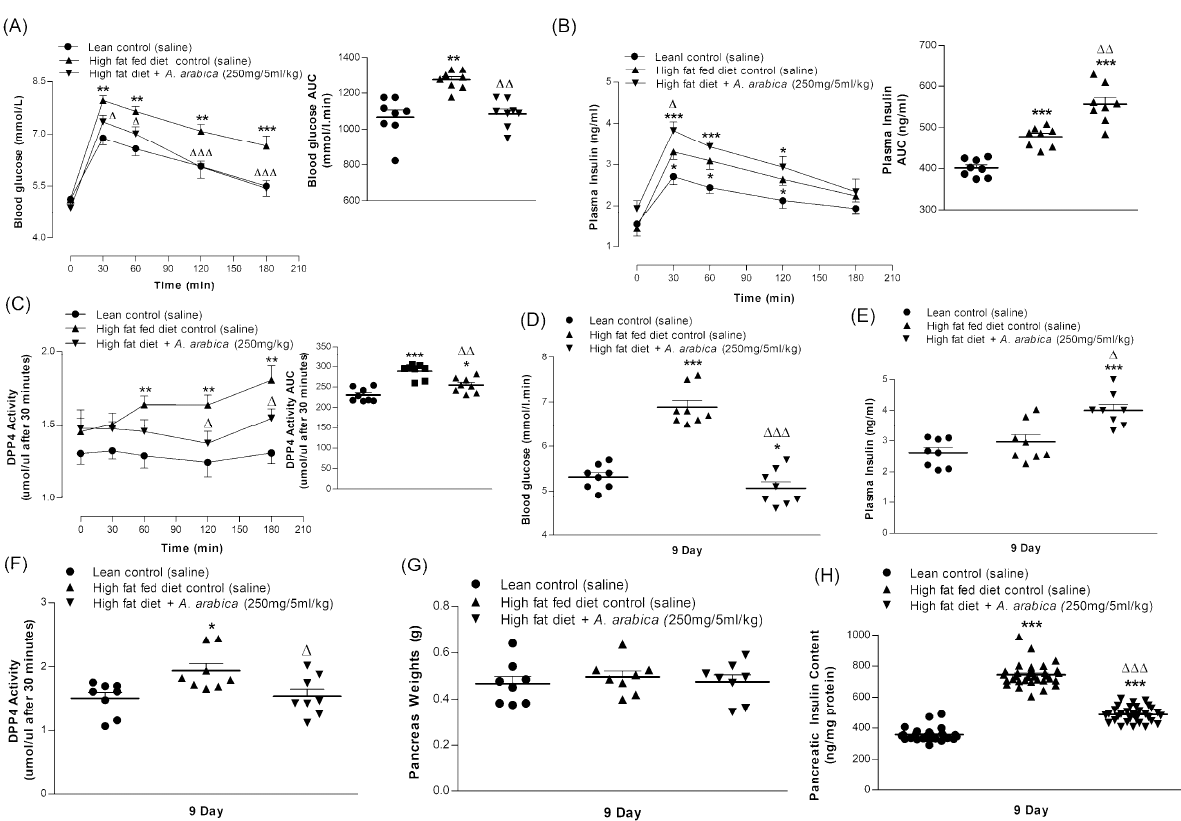
Figure 5. Chronic effects of twice-daily oral administration of hot-water extract of A. arabica bark on ( A ) glucose tolerance, ( B ) plasma insulin and ( C ) plasma DPP-IV on Day 6 and ( D ) blood glucose, ( E ) plasma insulin, ( F ) plasma DPP-IV, ( G ) pancreas weight and ( H ) pancreatic insulin content on Day 9 in high-fat-fed rats. Parameters were measured after treatment for 6 or 9 days with twice-daily oral administration of hot-water extract of A. arabica bark (250 mg/5 mL/kg body weight). Values are the mean ± SEM with n = 8 (~32 per group for pancreatic insulin content). * p < 0.05, ** p < 0.01 and *** p < 0.001 compared to lean control. ∆ p < 0.05, ∆∆ p < 0.01 and ∆∆∆ p < 0.001 compared to high-fat-fed control at corresponding time points.